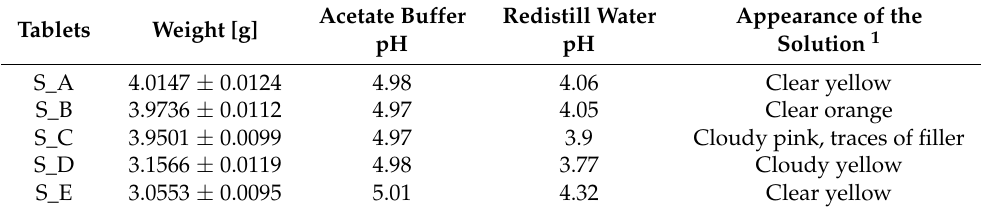
Table 2. Weights and measured pH values of prepared solutions; description of the appearance of